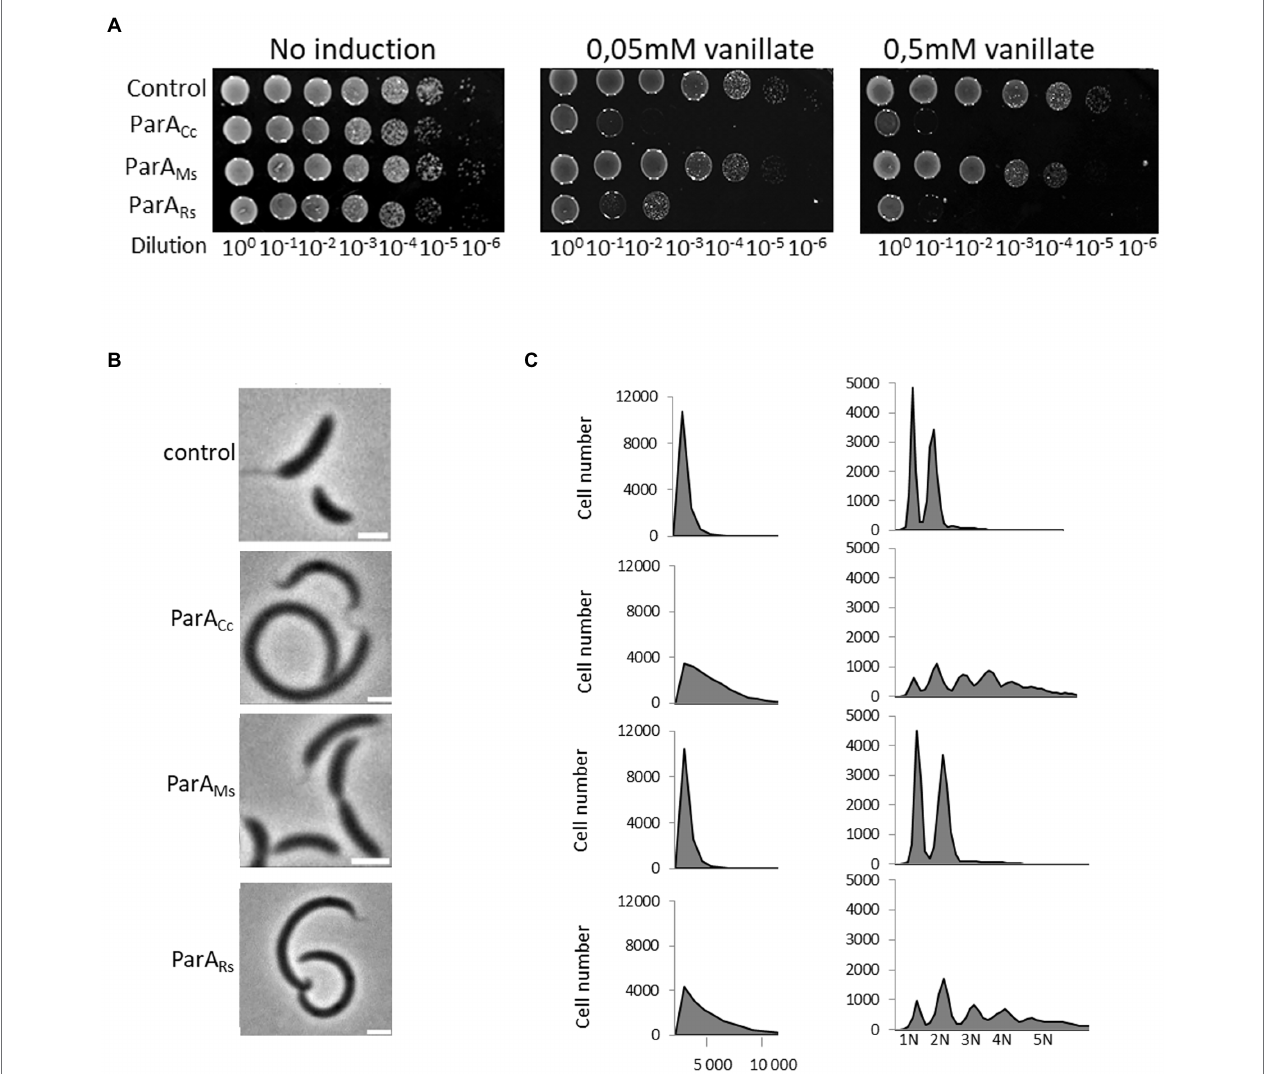
FIGURE 4 | Negative effects of overproduction of the endogenous and closely related R. sphaeroides ParA on C. crescentus growth and cell morphology. (A) Spot plating assay to determine viability of C. crescentus strains overproducing M. smegmatis ParA (ParA Ms ) and R. sphaeroides ParA1 (ParA Rs ) compared to the C. crescentus strain overproducing endogenous ParA (ParA Cc ; all in wild type background and additional parA copy under the control of the vanillate promoter with and without induction, as indicated). The C. crescentus strain containing empty vector served as a control. (B) Phase contrast images of C. crescentus strains overproducing M. smegmatis ParA (ParA Ms ) and R. sphaeroides ParA1 (ParA Rs ) compared to C. crescentus strain overproducing endogenous ParA (ParA Cc ; as described above) and to the control strain with empty vector (control). Scale bar: 2 μ m. (C) Flow cytometry profiles showing the cell length and chromosome numbers for C. crescentus strains overproducing M. smegmatis ParA (ParA Ms ) and R. sphaeroides ParA1 (ParA Rs ) compared to the C. crescentus strain overproducing endogenous (ParA Cc ; as described above) and to the control strain with empty vector